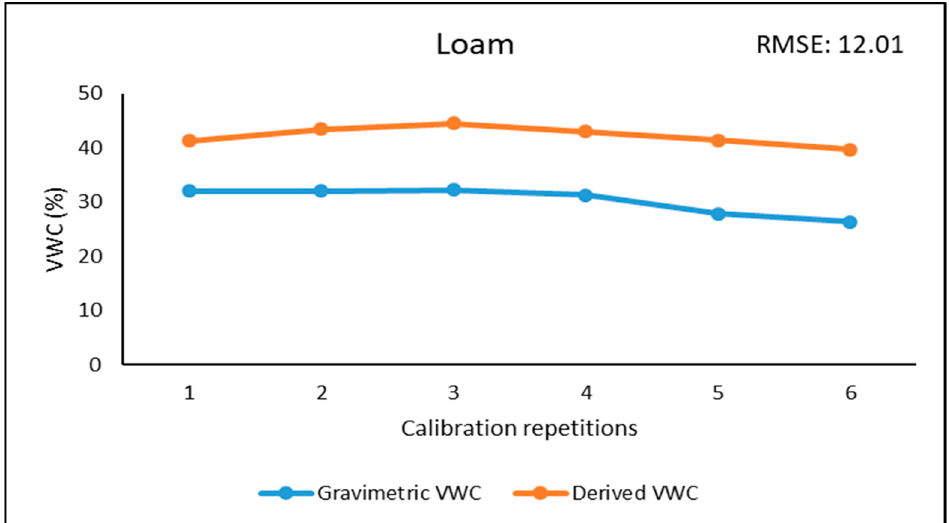
Figure 12. Loam Field VWC compared with derived VWC.